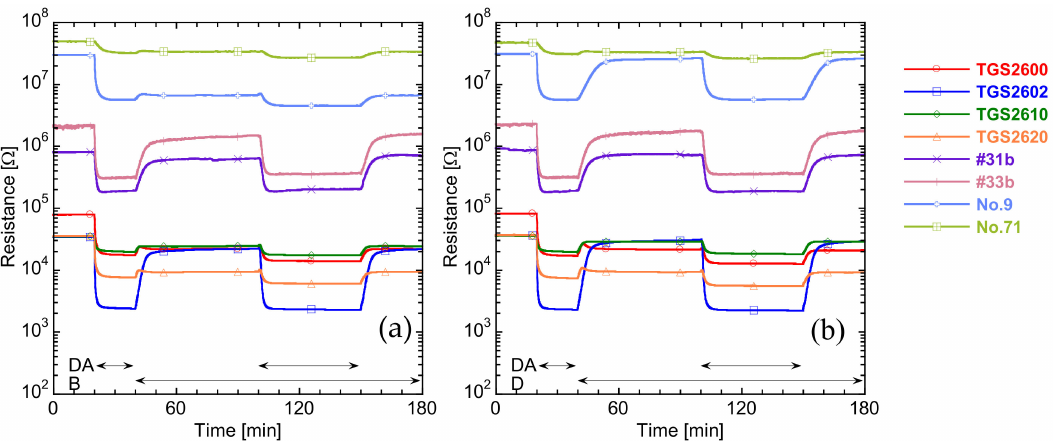
Figure 4. Dynamic resistance response of eight sensors to 5.4 ppm of diacetyl (DA) and 5.4 ppm of diacetyl with contaminant gases: ( a ) 2.7 ppm of butyl acetate (B) and ( b ) 1.0 ppm of n -decane (D). Graphs indicate flow periods of DA, B, and D.